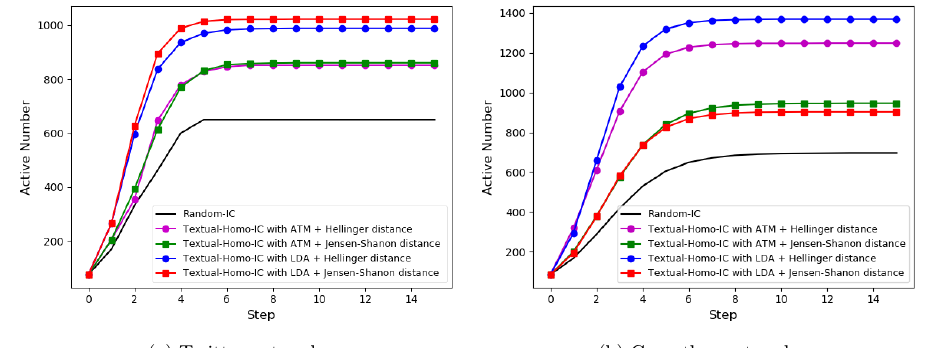
Fig. 6. Textual-Homo-IC di®usion on static